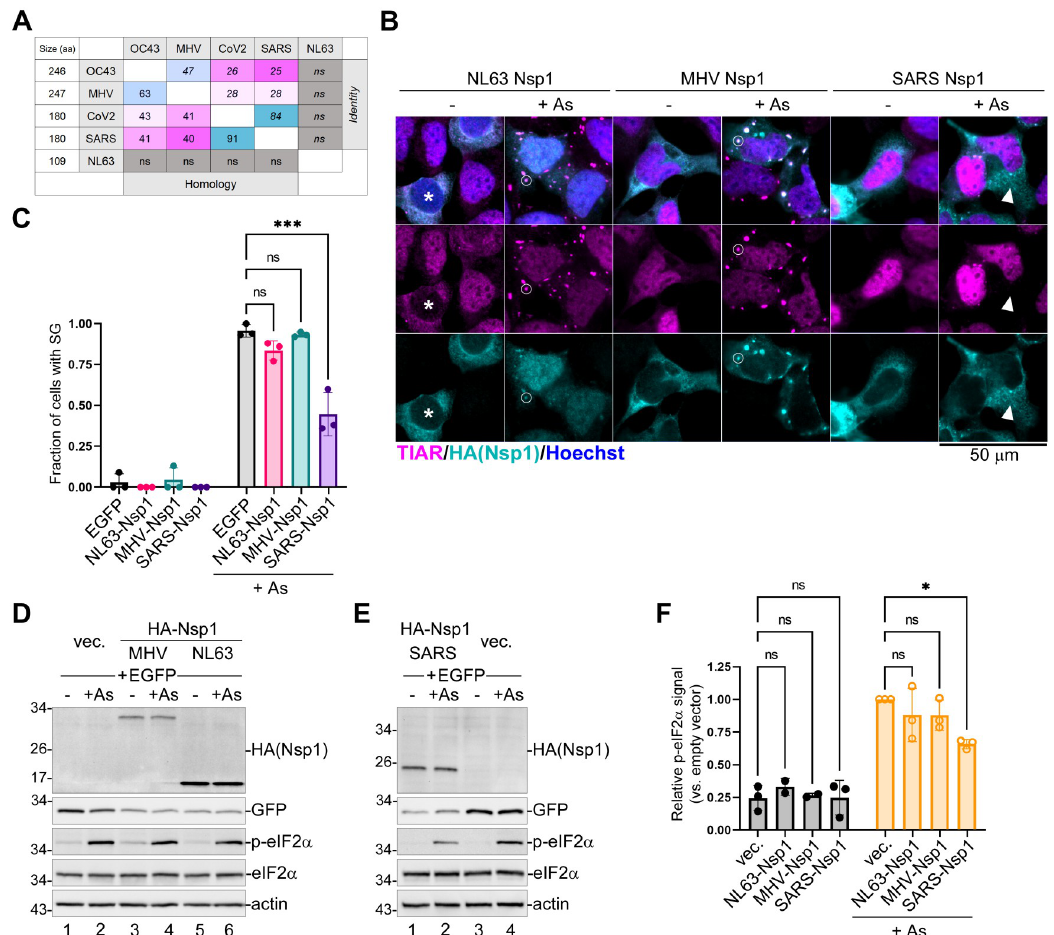
Fig 7. Nsp1 protein of SARS CoV, but not NL63 or MHV, inhibits SG formation. (A) Table showing percent homology (lower left) and identity (upper right) between primary amino acid (aa) sequences of Nsp1 proteins from the indicated coronavirus species as determined by pairwise NCBI BLAST alignment (https://blast.ncbi.nlm.nih.gov/Blast.cgi), ns = no significant homology. Amino acid sequences of mature Nsp1 proteins were obtained from the following accession numbers in the NCBI Protein database: YP_009555238 (OC43), NP_045299 (MHV), YP_009724389 (CoV2), YP_009944365 (SARS), and AFD98833 (NL63). (B) 293A cells were transiently transfected with the indicated HA-tagged Nsp1 expression constructs. At 24 h post-transfection cells were treated with sodium arsenite (+ As) and SG formation analysed by immunofluorescence microscopy staining for TIAR (magenta). HA-tagged Nsp1 signal is shown in teal and nuclei stained with Hoechst dye are shown in blue. Scale bar = 50 μ m. Asterisk marks the NL63 Nsp1-expressing cell with depleted nuclear TIAR signal, circles highlight SGs that formed in NL-63 and MHV-expressing cells, and an arrowhead marks the SARS Nsp1-expressing cell that did not form SGs upon As treatment. (C) Fraction of transfected cells with As-induced SGs quantified from B and control EGFP-transfected cells. Each data point represents independent biological replicate (N = 3). Error bars = standard deviation. Two-way ANOVA and Tukey multiple comparisons tests were done to determine statistical significance ( ��� , p -value < 0.001; ns, non-significant). (D,E) Whole cell lysates from cells treated as in B with or without As were analysed by western blot. (F) Phospho-eIF2 α band intensity normalized to total eIF2 α was quantified from D and E and plotted relative to phospho-eIF2 α level in EGFP control cells treated with As. Each data point represents independent biological replicate (N = 3). Error bars = standard deviation. Two-way ANOVA and Tukey multiple comparisons tests were done to determine statistical significance ( � , p-value < 0.05; ns,